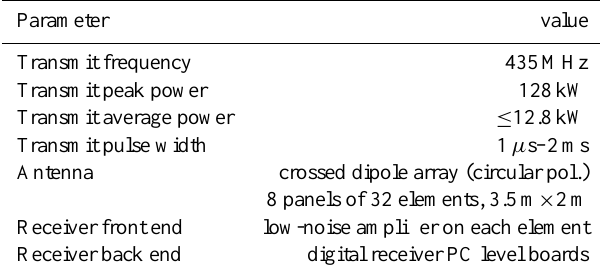
Table 1. AMISR prototype